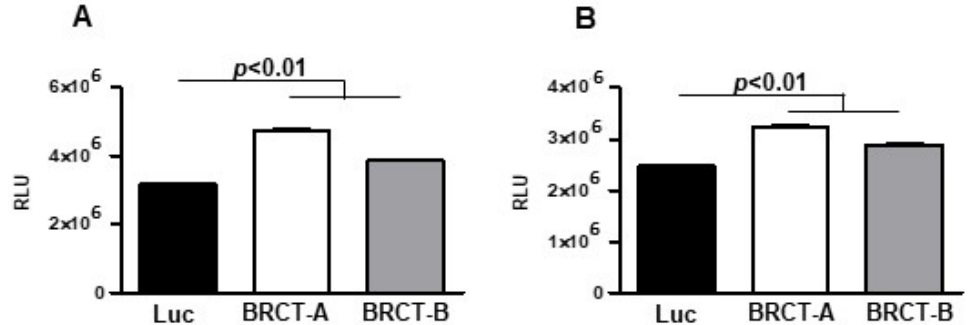
Figure 2. Analysis of BRCT domain from LmjPES protein expression on the capacity of mammal cells to produce ATP. ATP levels (measured as relative light unit: RLU) produced by lentiBRCT (BRCT-A, BRCT-B) or lentiLuc (Luc) infected HEK293T ( A ) and NIH/3T3 ( B ) cells. The values represent the mean ±SD of sextuplicates from a representative experiment of the three carried out.